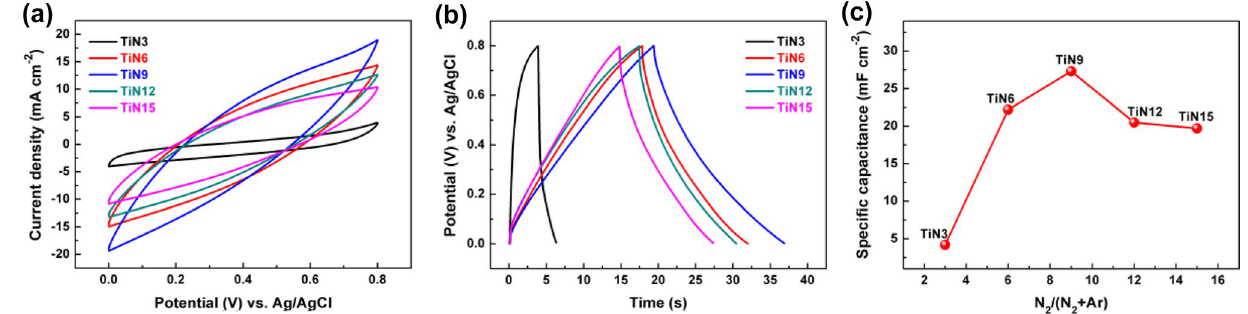
Fig. 4 Electrochemical performance of TiN thin film electrodes using a three-electrode system: a CV curves at a scan rate of 1 V s −1 , b GCD curves at a current of 1.0 mA cm −2 and c Relationship of the specific capacitance with respect to N 2